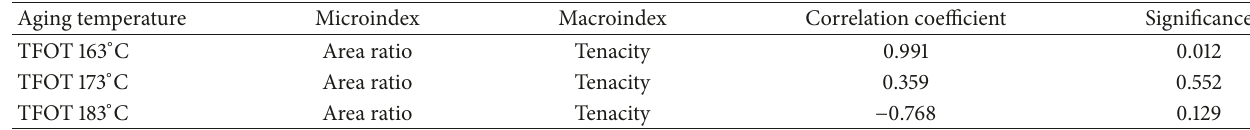
Table 7: Correlation of microstructure quantitative indexes and tenacity with aging